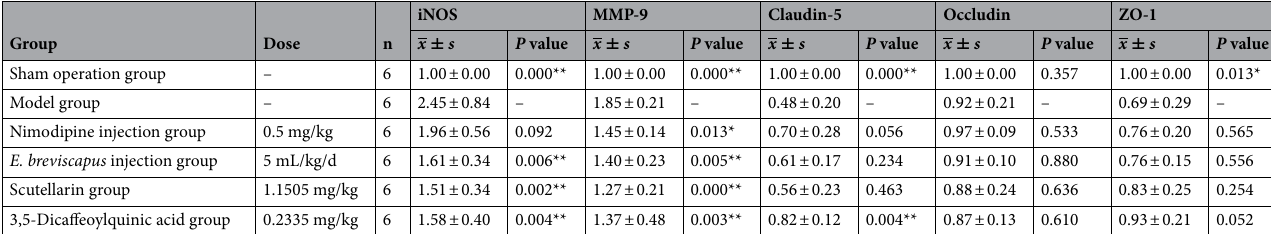
Table 6. Effects of drugs on the expression of iNOS, MMP-9, claudin-5, occludin and ZO-1protein levels in the ischemic brain tissue of MCAO rats.